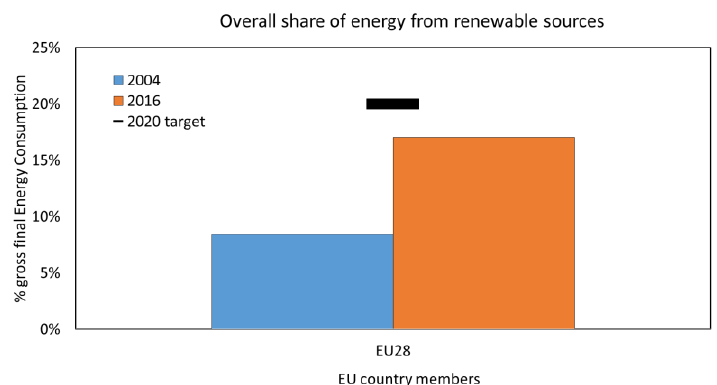
Figure 4. Overall share of energy from renewable sources in the overall European Union, with the percentage of share in 2004 and 2016 and the target for 2020. Based on data provided by Eurostat [19].